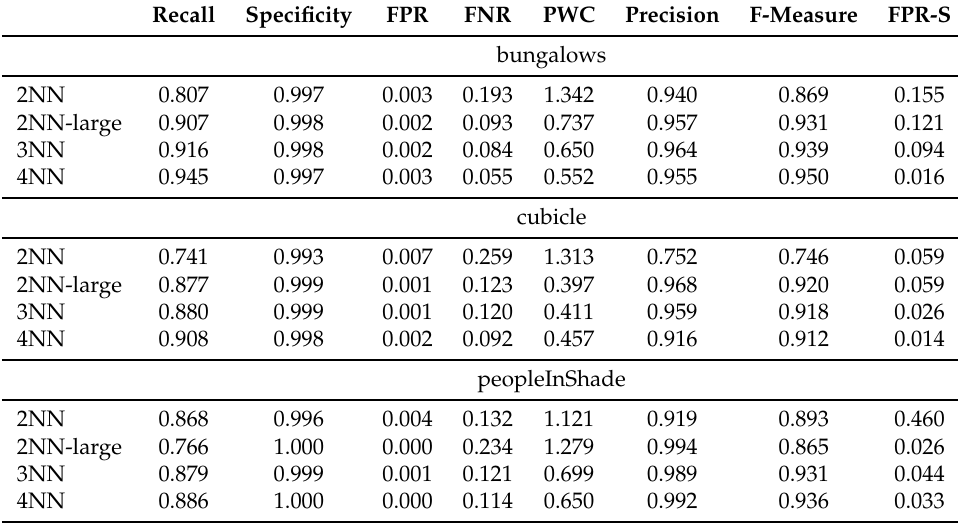
Table 2. Performance results of four networks on three sequences of the shadow category in the CD2014 dataset [7]. FPR, FPR-S, FNR, and PWC denote false positive rate, FPR in only shadows, false negative rate, and percentage of wrong classifications, respectively.